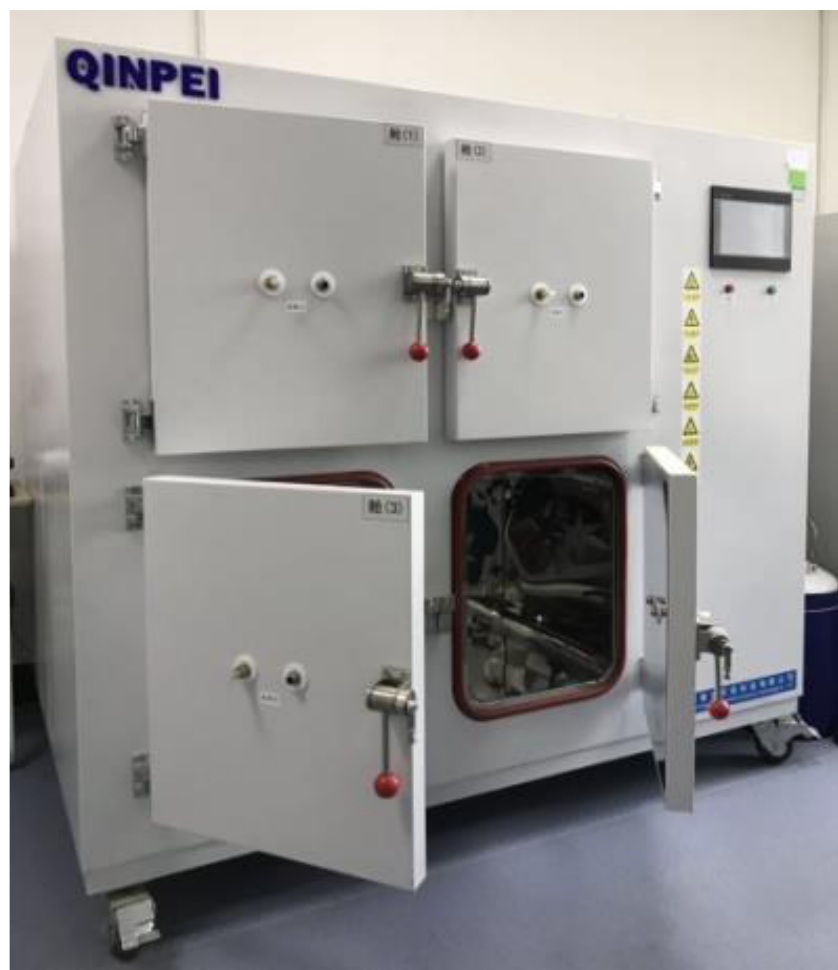
Figure 2. Physical picture of environmental chamber.